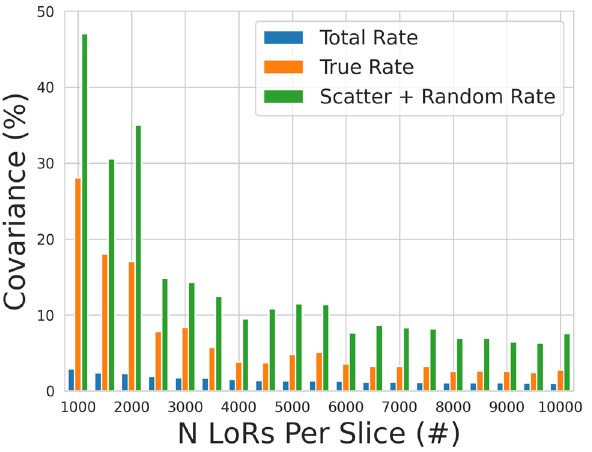
Figure 7. The covariance of the total, true, and scattered plus random count rates for the 800 mm and 2 MBq simulation as a function of the number of LoRs used to generate a projection image.